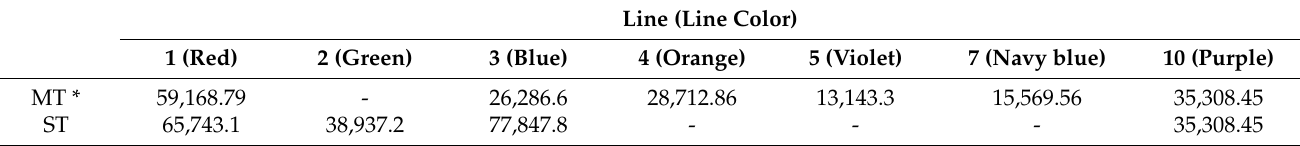
Table 10. Total energy consumption of all lines under scenario 2